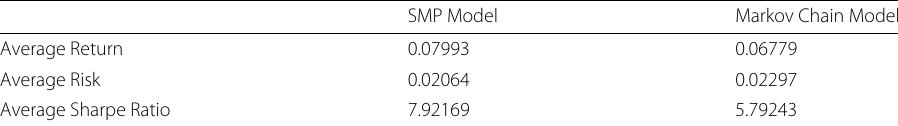
Table 5 Comparison of the results for two models SMP Model Markov Chain Model Average Return 0.07993 0.06779 Average Risk 0.02064 0.02297 Average Sharpe Ratio 7.92169